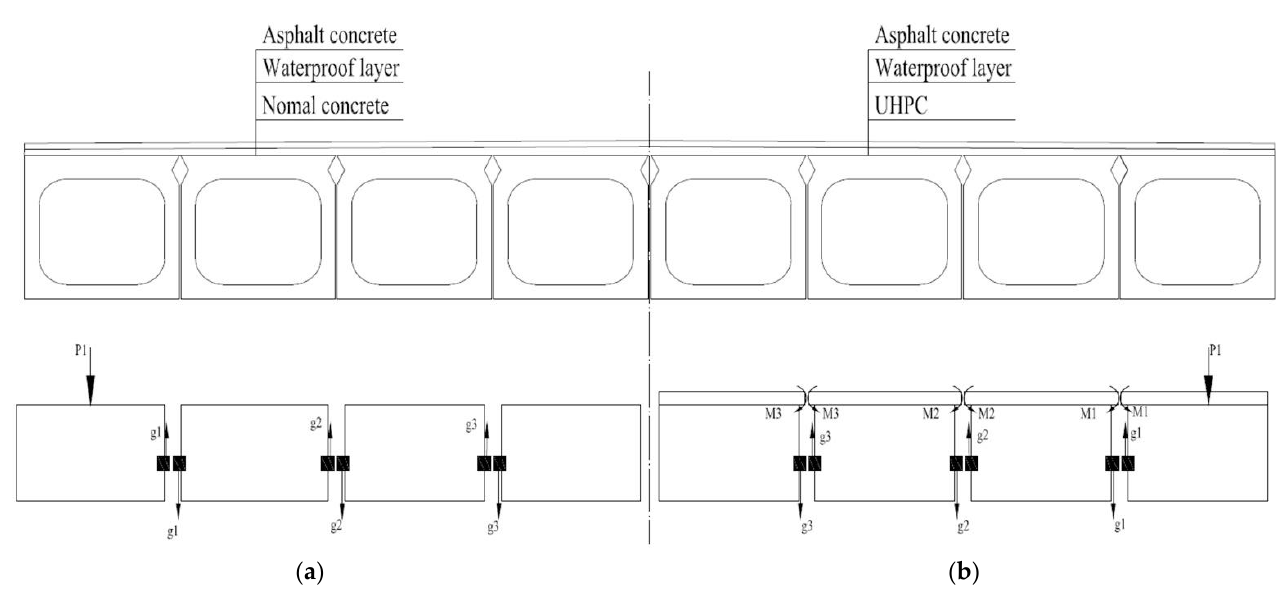
Figure 4. Different mechanics modes of hinge joints. ( a ) Mechanics mode of the common hinge for transmission of shear. ( b ) New mechanics mode of the hinge with a stronger pavement structure.